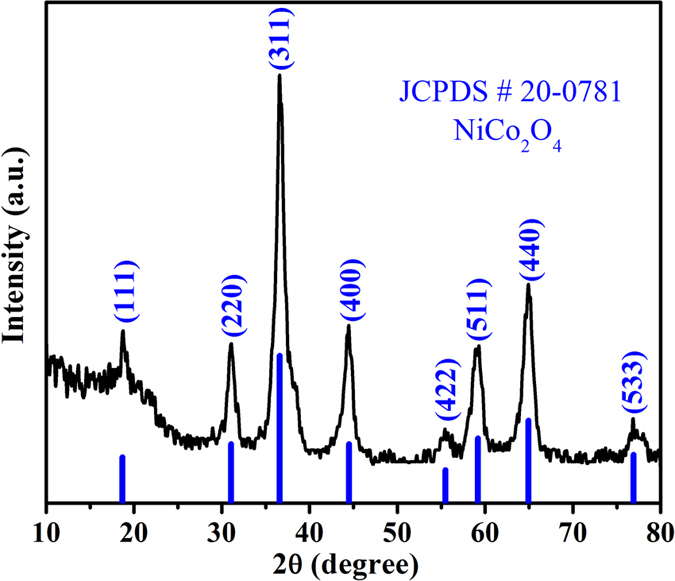
XRD pattern of as-synthesized porous NiCo2O4 microspheres.